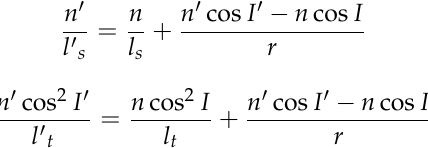
where l s and l s (cid:48) represents sagittal object distance (SOD) and sagittal image distance (SID), respectively, l t and l t (cid:48) represents tangential object distance (TOD) and tangential image distance (TID), respectively, I and I (cid:48) represent the angle of incidence and the angle of refraction, n and n (cid:48) represent the refractive index of object space and image space, and r represents the radius of curvature of the surface. When Equations (1) and (2) are applied to a mirror, the angle of reflection could be viewed as the angle of refraction. According to Snell’s law, the angle of refraction and the angle of reflection have the same value, but the direction is opposite ( I (cid:48) = − I )